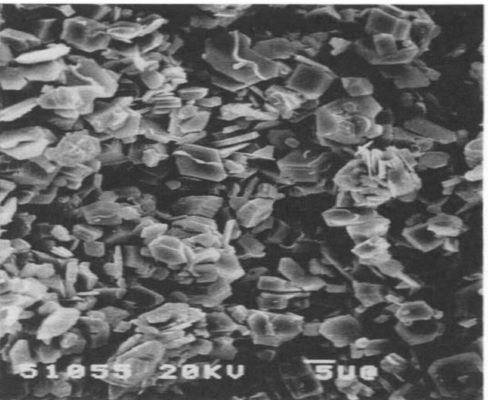
Figure 10. Sandstone core from Tuscaloosa reservoir in pre-flow conditions (note the intact authigenic kaolinite in the pore system) [66].